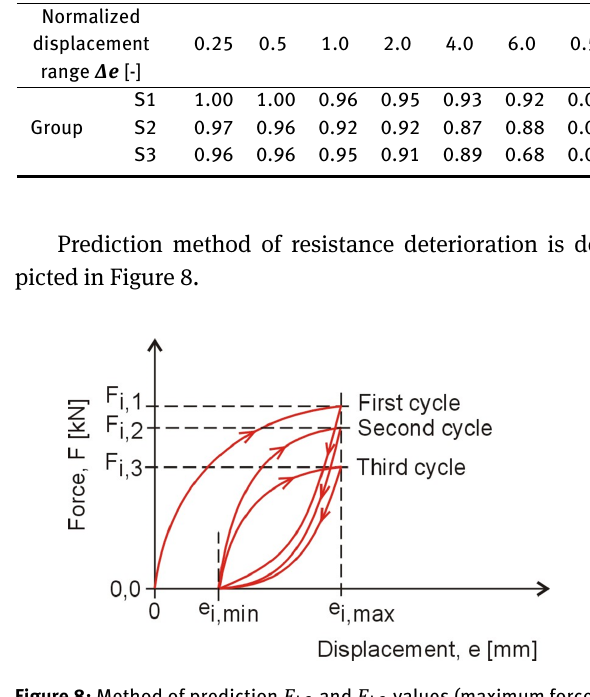
Figure 8: Method of prediction F i ,3 and F i ,3 values (maximum forces in the first and third cycle at the same range of displacement ∆e ) as a part of evaluation of the ε ( ∆e ) .